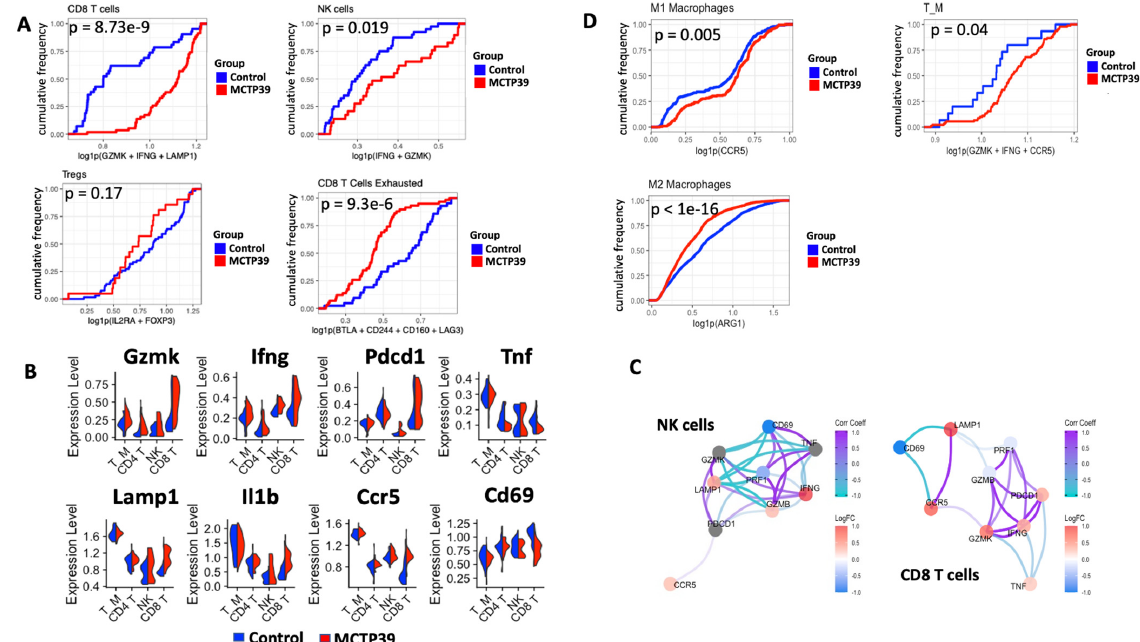
Figure 3. Cell population changes following WHSC1 inhibition. ( A ) Cumulative frequency of lymphocytic populations in control mice (blue) and MCTP39-treated mice (red). Population frequency (0 to 1) is shown on the y axis, expression levels of the markers in the axis name is shown on the x axis. Significance was calculated using the Kolmogorov–Smirnov test, with p values shown in the figure. ( B ) Expression levels of the markers used to classify activated lymphocytes. Each violin plot is split for the control group (blue) and the MCTP39-treated group (red). ( C ) Correlation network analysis of the cytotoxic markers expressed in NK (left) and CD8 + T cells (right). ( D ) Cumulative frequency of myeloid populations in the control (blue) and MCTP39-treated samples (red). Significance was calculated using the Kolmogorov–Smirnov test, with p values shown in the figure.